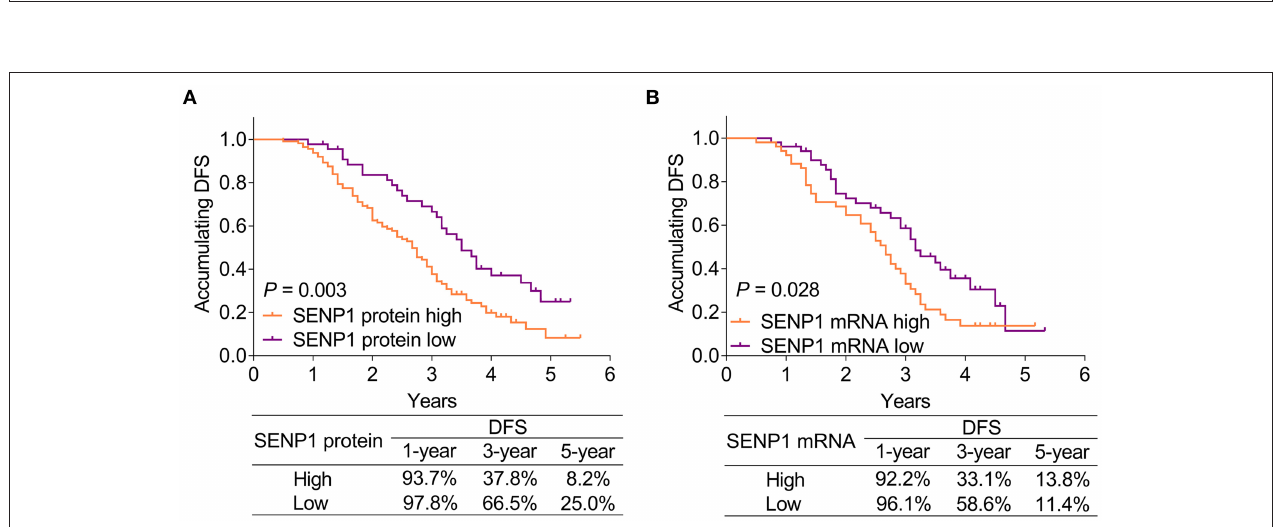
FIGURE 3 | Comparison of accumulating DFS between patients with surgical NSCLC with different SENP1 expressions. Comparison of accumulating DFS between patients with surgical NSCLC with SENP1 protein high and SENP1 protein low (A) and comparison of accumulating DFS between patients with surgical NSCLC with SENP1 mRNA high and SENP1 mRNA low (B) . SENP1, small ubiquitin-like modifier (SUMO)-specific protease 1; DFS, disease-free survival; NSCLC, non-small cell lung cancer.